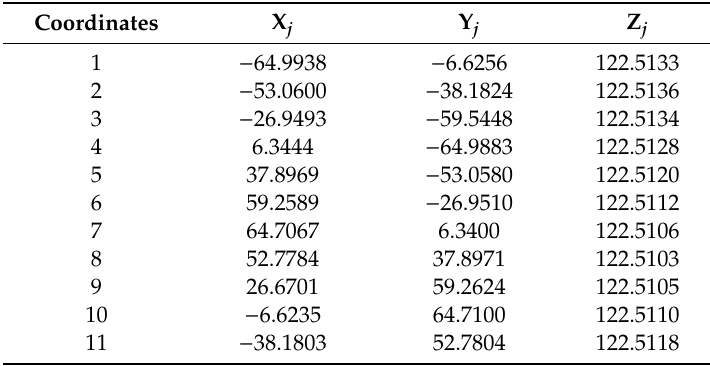
Figure 7. Schematic diagram of the fitting plane. According to Equation (21) and the obtained values of the coe ffi cients of the plane equation ( a , b , c , e ), λ = − 0.0013 was calculated. The optimized coordinates of laser tracer stations are shown in Table 2. Table 2. Optimized coordinates of laser tracer stations (unit: mm).